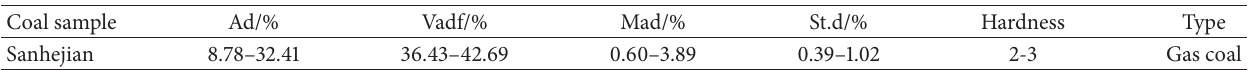
Figure 1: Schematic diagram for ultrasonic testing of coal samples. 1: compression testing machine, 2: support block, 3: sample, 4: ultrasonic transducer,5:shieldingsystem,6:AEreceivingprobe,7:preamplifiers,8:loadingcontrolsystem,9:ultrasonicsignalsemissionandacquisition system, and 10: electromagnetic shielding room. Table 1: The coal type and